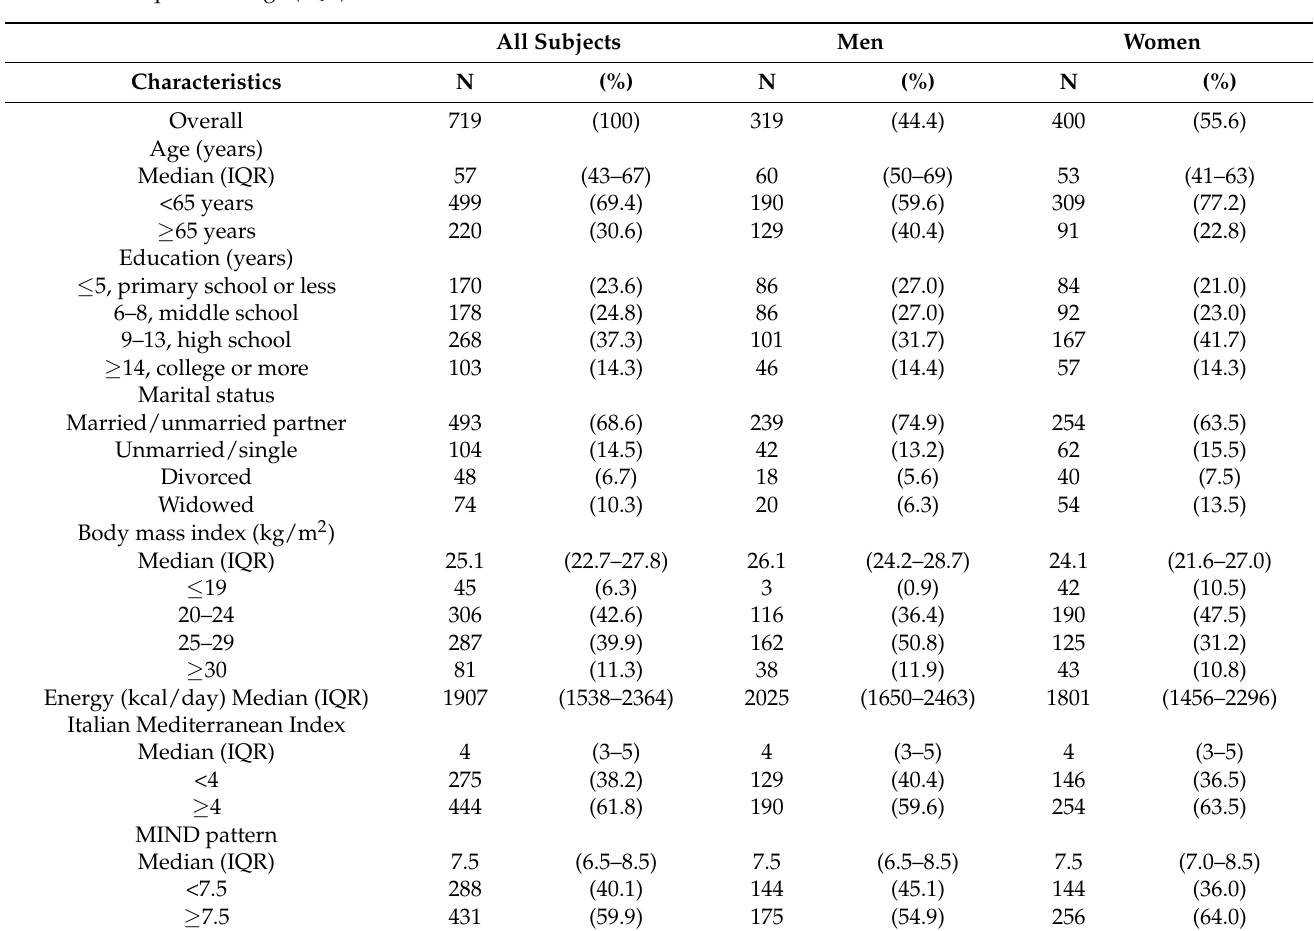
Table 1. Characteristics of study participants. Number (percentage-%) reported when not otherwise indicated and median and interquartile range